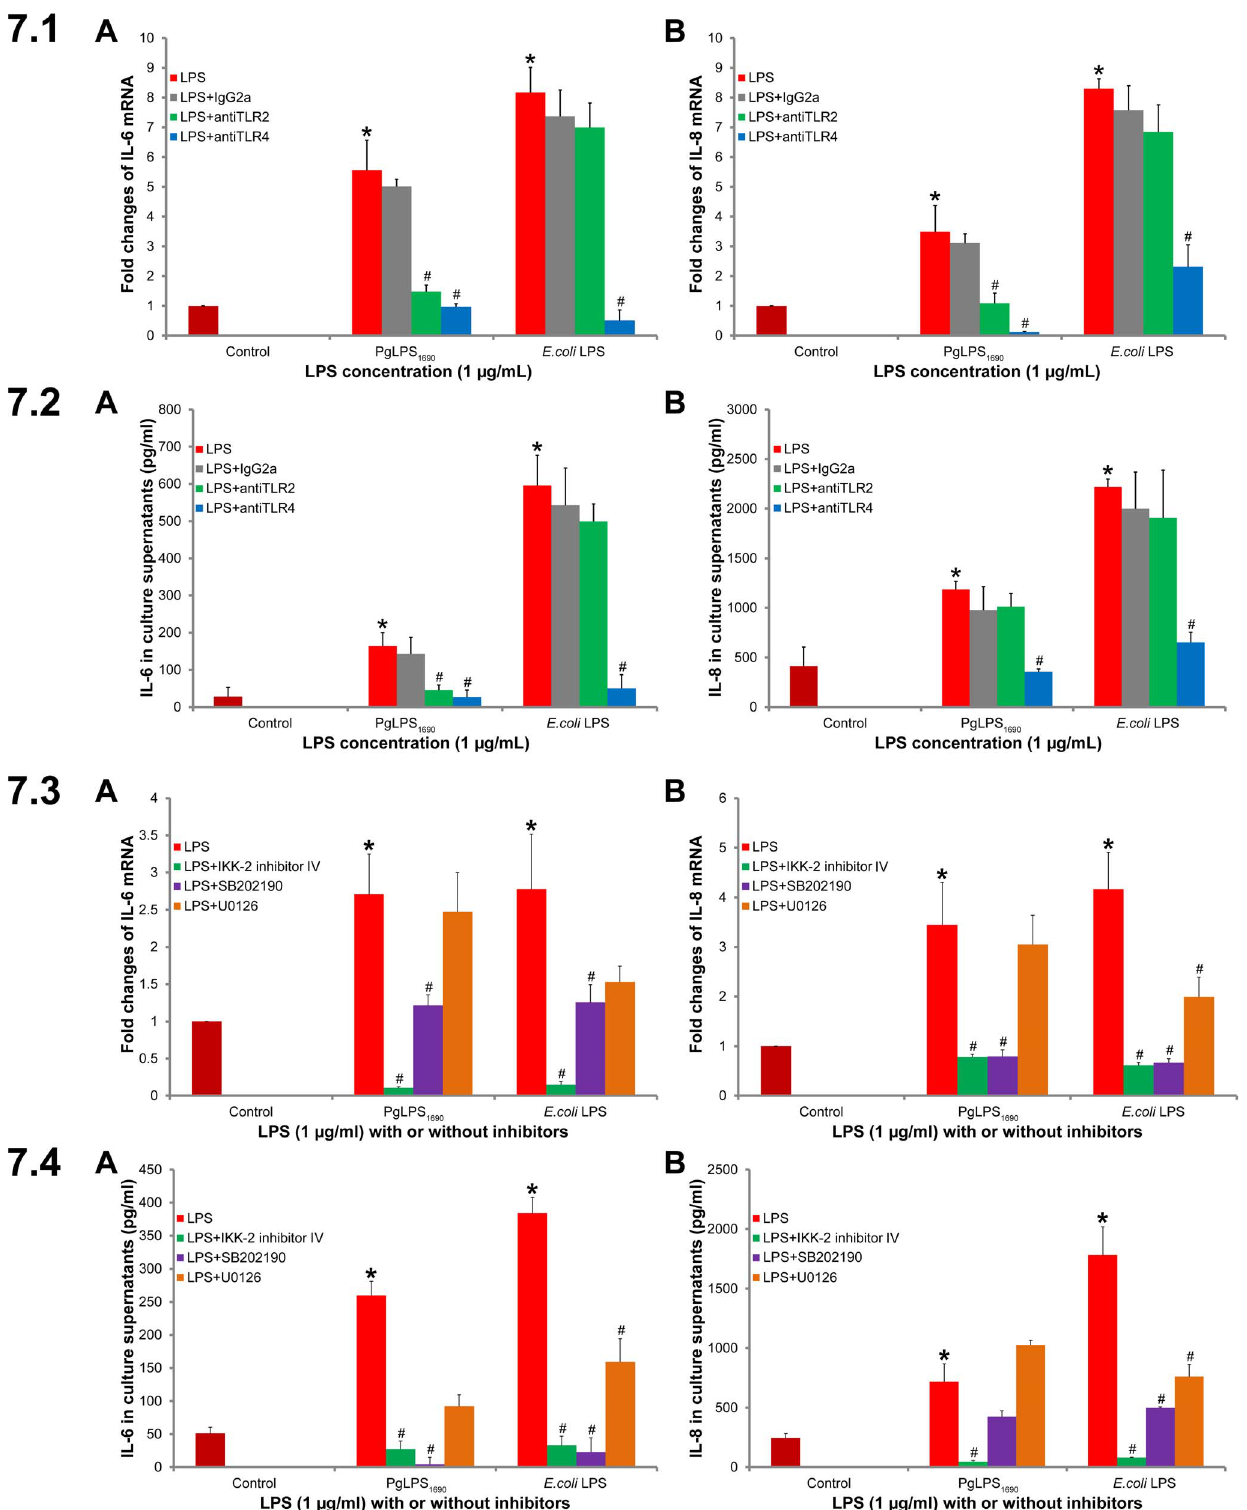
Figure 7. Blocking assay on the involvement of TLR2/TLR4 and signal transduction pathways in P. gingivalis (Pg) LPS 1690 (PgLPS 1690 )- and E.coli LPS-induced expression of IL-6 and IL-8 in HGFs. The cells were pretreated for 1 h with anti-TLR2 and anti-TLR4 antibodies in serum free medium, and then treated with PgLPS and E. coli LPS at 1 m g/ml for additional 12 h. Total RNA and cell culture supernatants were collected and analyzed for IL-6 (A) and IL-8 (B) by quantitative real-time PCR and ELISA, respectively. The histograms show IL-6 (7.1A) and IL-8 (7.1B) mRNA levels of three independent experiments, and IL-6 (7.2A) and IL-8 (7.2B) protein expression levels of two independent experiments. The results were presented as mean 6 SD. Calculation of significant difference were made in comparison to the controls without LPS treatment (* p -value